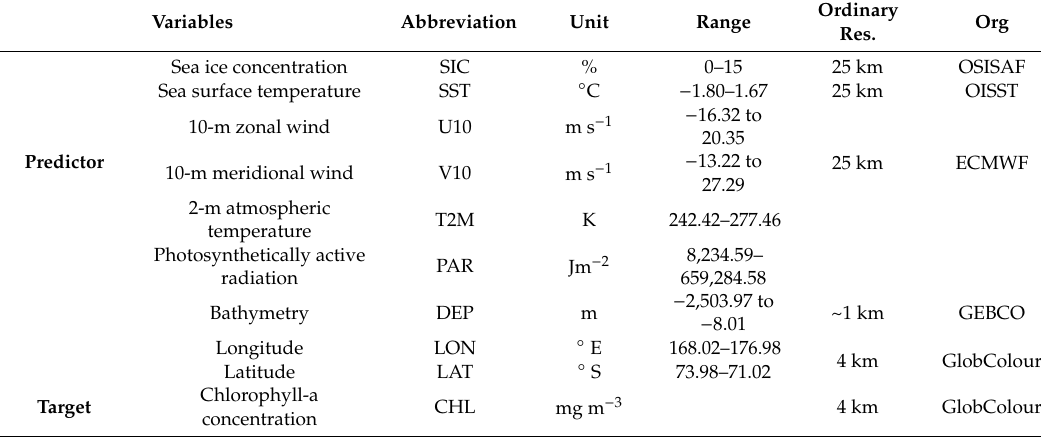
Table 1. Predictor and target datasets for the CHL prediction models. All input data were bi-linearly interpolated into 4 km × 4 km, which is the spatial resolution of satellite-derived CHL data. All data are daily and confined to the periods from the 1997 / 1998 summer season to 2017 / 2018 summer season when the CHL data are available. The absolute value of each datum was used in the